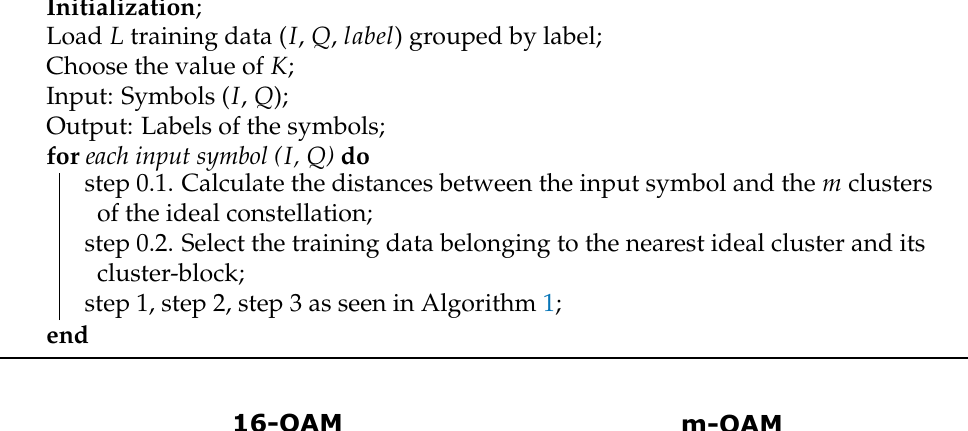
Algorithm 2: Modified KNN algorithm for m-QAM demodulators